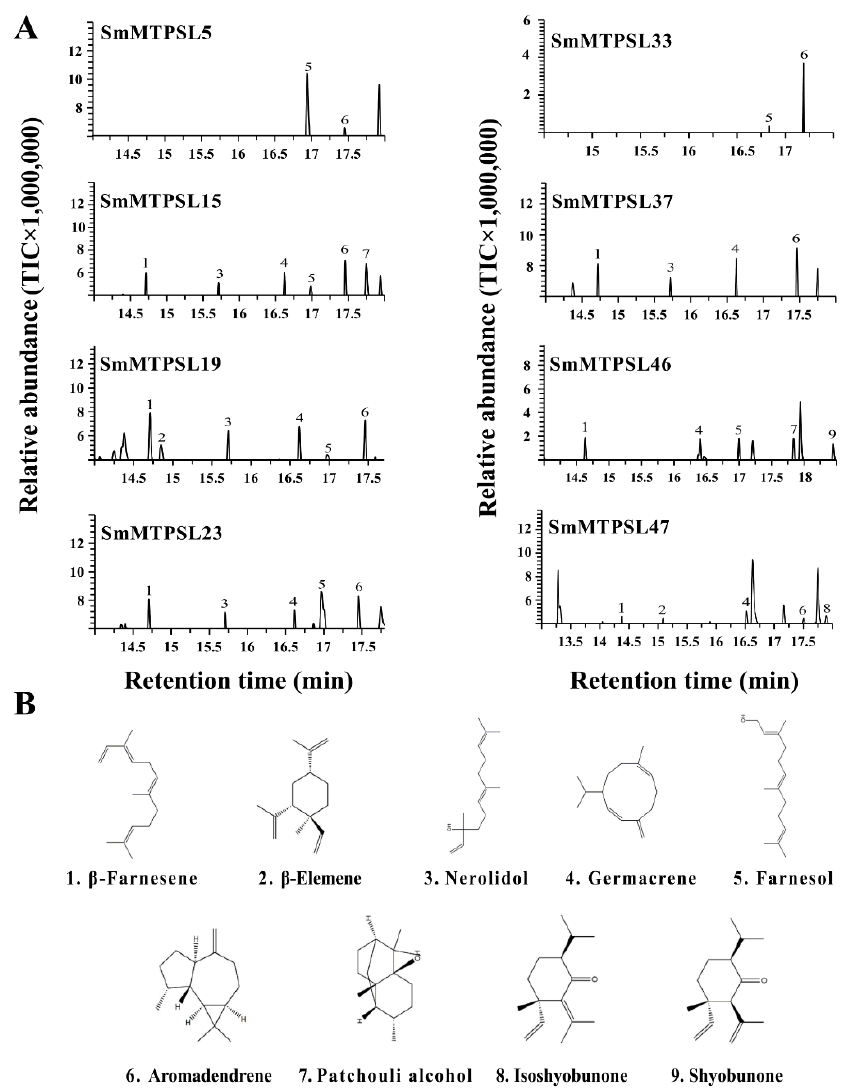
Figure 5. GC-MS of the products generated in vitro by eight recombinant SmMTPSLs proteins provided with FPP as the substrate. ( A ) Total ion chromatogram of the sesquiterpene products and ( B ) their structure. Products were identified as 1: β-farnesene; 2: β-elemene; 3: nerolidol; 4: germacrene; 5: farnesol; 6: aromadendrene; 7: patchouli alcohol; 8: isoshyobunone; 9: shyobunone.